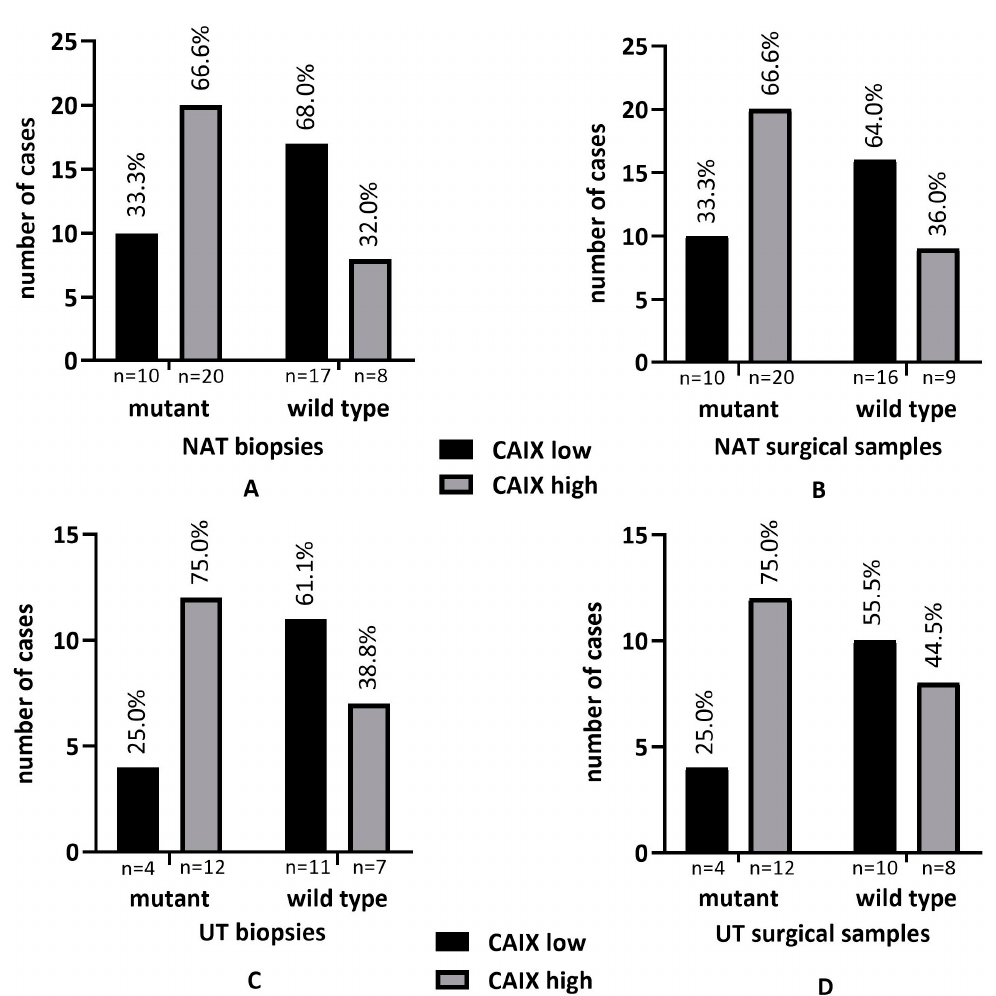
Figure 7. Correlation between KRAS status and CAIX expression in biopsies and post-treatment surgical samples of NAT ( A , B ) and biopsies and untreated surgical samples of UT ( n = 34) rectal adenocarcinoma cases ( C , D ).